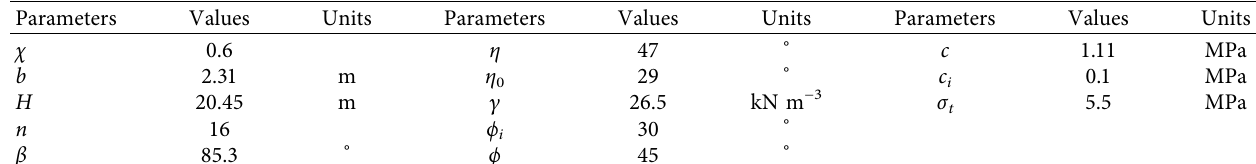
Table 3: Calculation parameters of rock mass of rock slope facing the Tehran-Chalus Road [36].